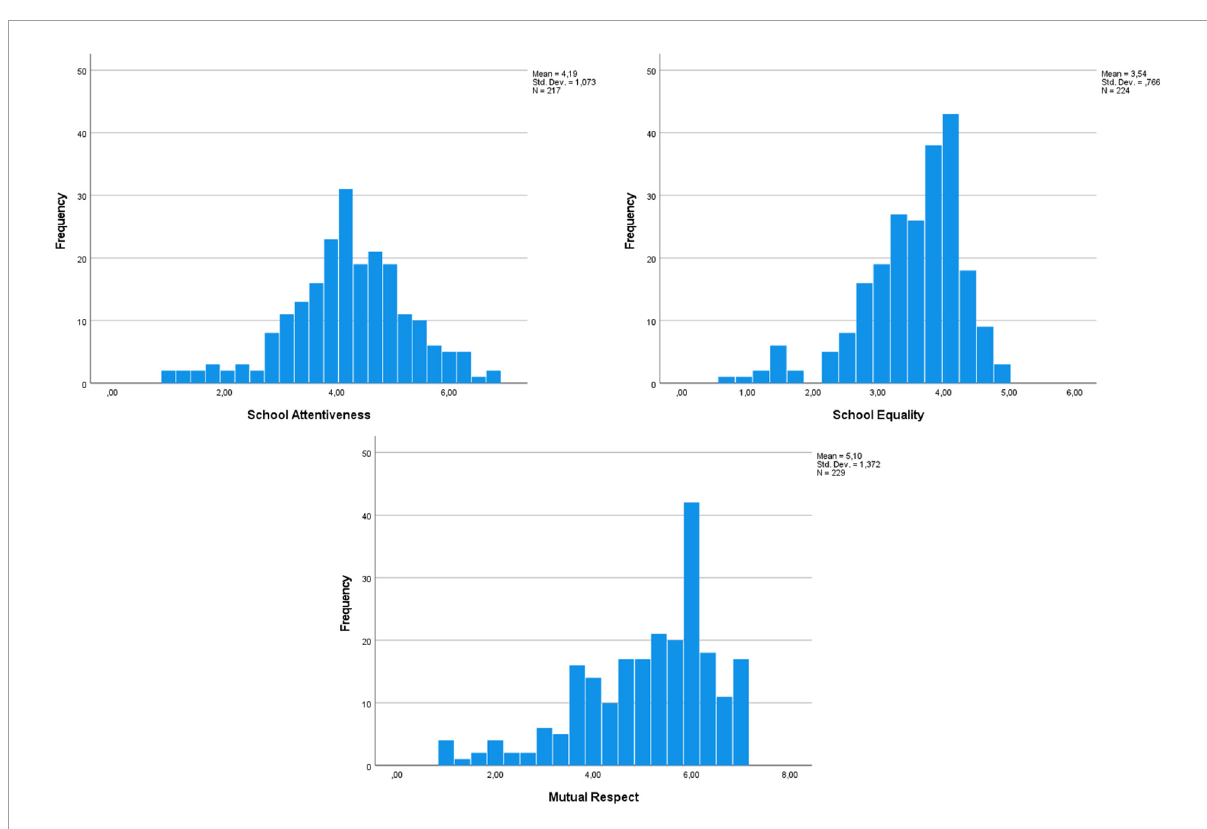
FIGURE1 Response distributions of the resilience